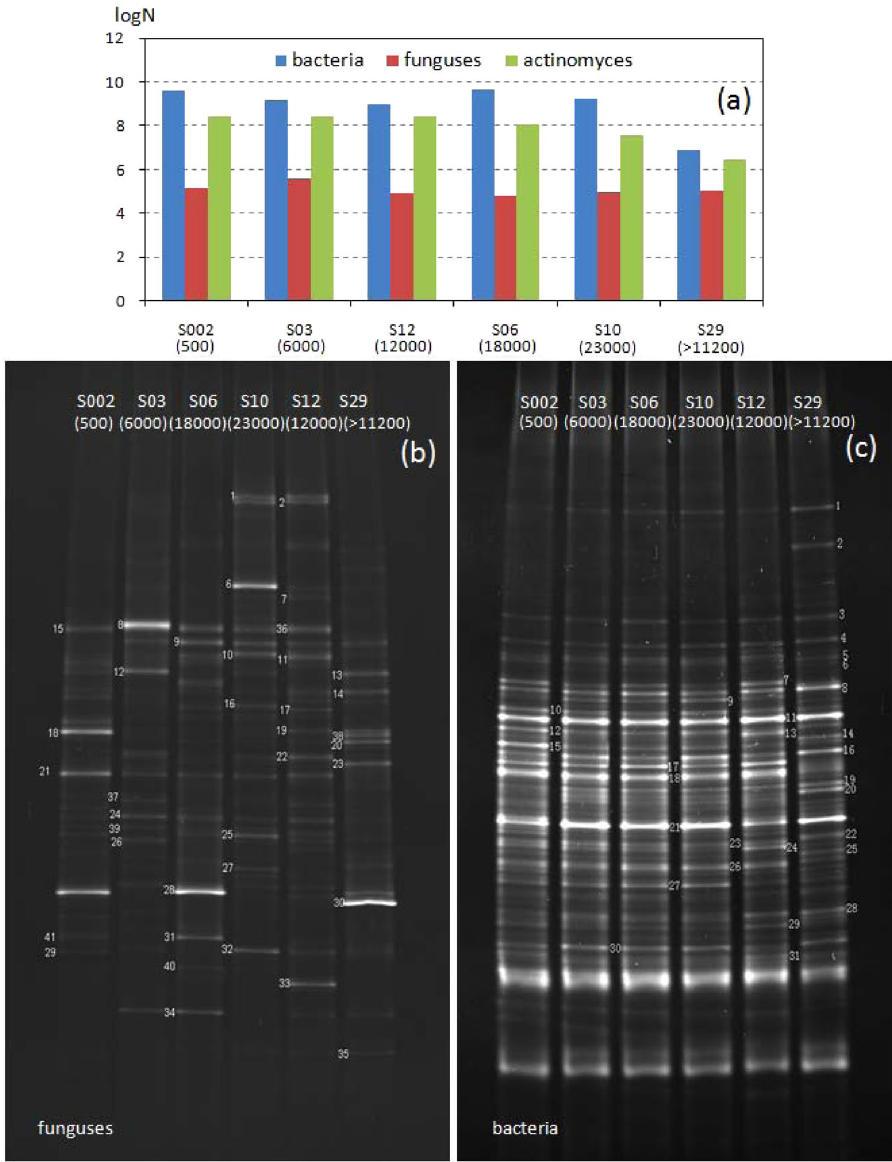
Figure 4. Amounts of bacteria, funguses and actinomyces under CO 2 invasion ( a ), and 16 S rDNA-DGGE fingerprint patterns of the soil funguses and bacteria ( b , c